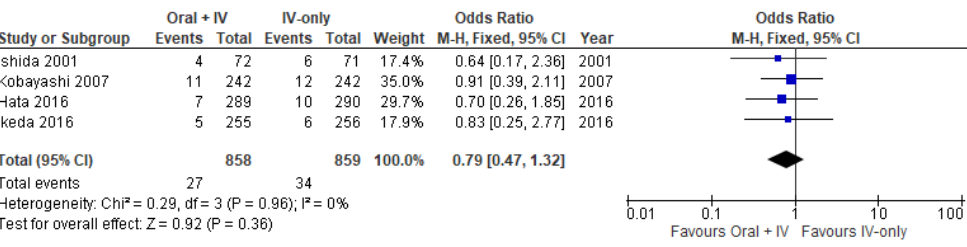
Figure 4. Forest plot of organ/space SSIs comparing oral + IV group and IV-only group.